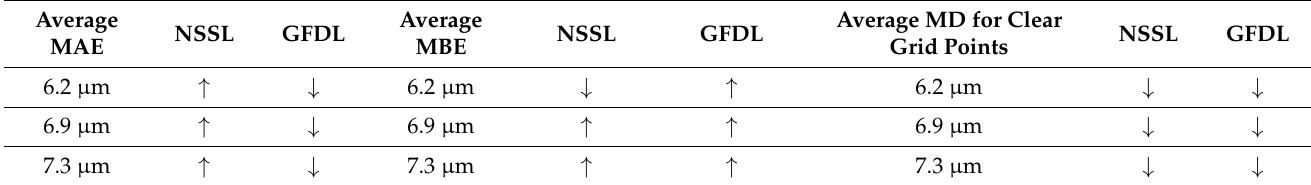
Table 3. Comparison of average mean absolute error (MAE), mean bias error (MBE), and mean difference (MD) of clear grid points between the Thompson MP scheme and the NSSL and GFDL MP schemes. Bold arrows indicate that the averages are statistically different at the 95th percentile based on Student’s t